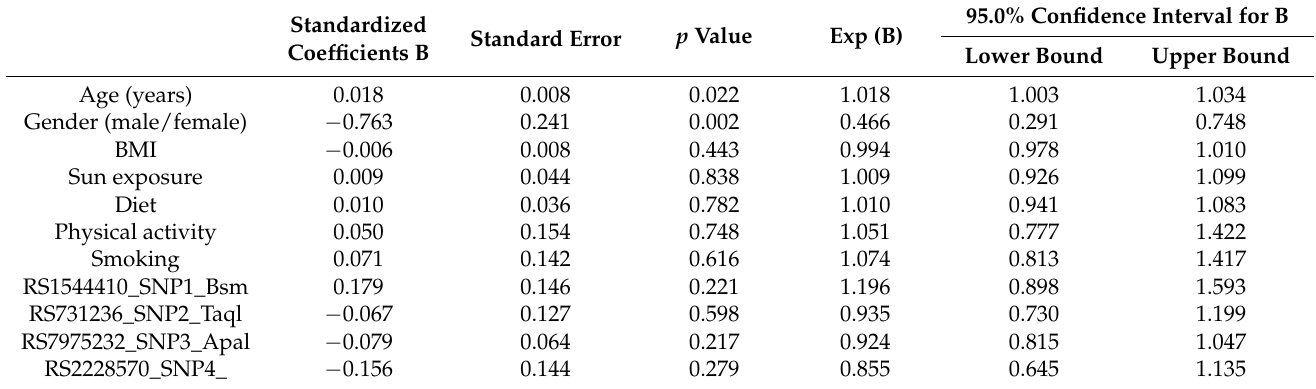
Table 4. Multiple logistic regression analysis of the influence of four VDR gene polymorphisms and some clinical prognostic variables on vitamin D status (deficiency vs. insufficiency/optimal) of study